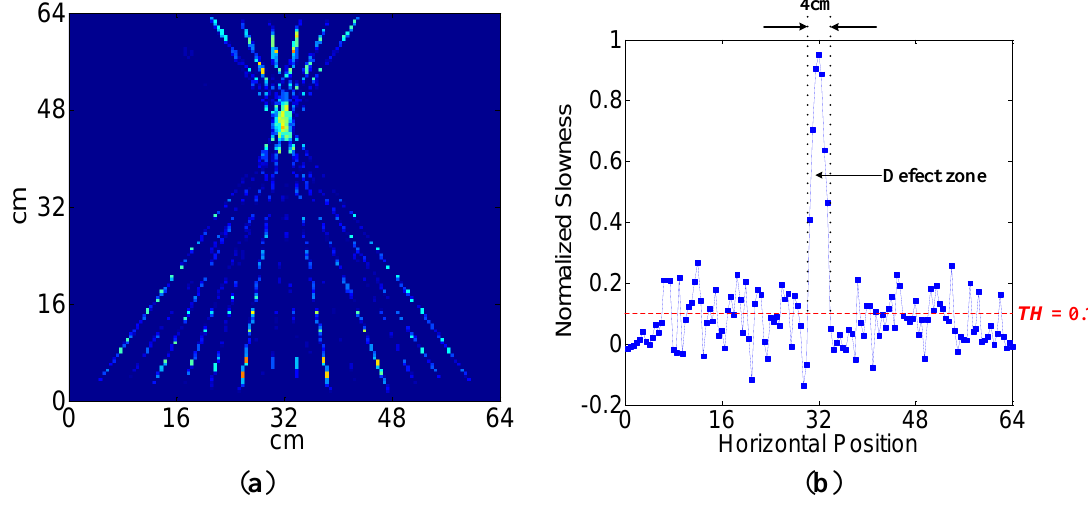
Figure 11. Results of the ULW TI experiment. ( a ) The TI result and ( b ) the slowness curve on the cross section at a position of y = 44 cm for the reconstructed